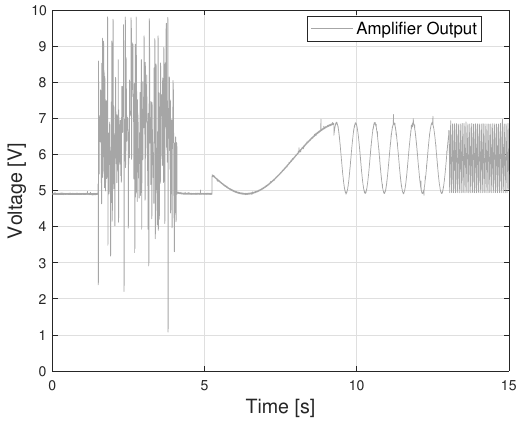
Figure 12. Voltage time history.